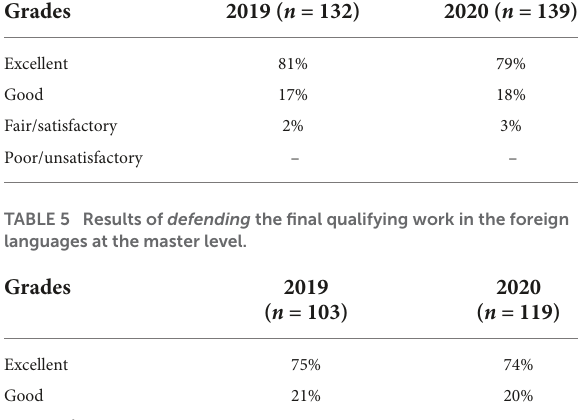
TABLE 4 Results of defending the final qualifying work in the foreign languages at the bachelor level.